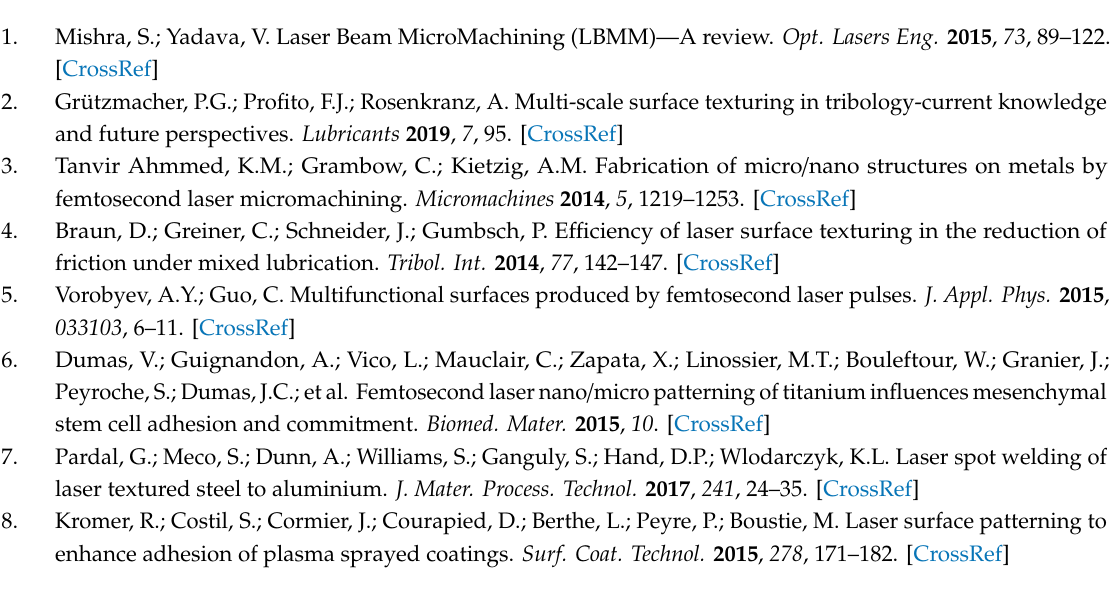
Figure S1: SEM image of circular columns produced on tungsten surface by shifted burst method, Figure S2: SEM image of inclined circular columns produced on tungsten surface by shifted burst method, Figure S3: SEM image of donut holes produced by shifted path method on Al 2 O 3